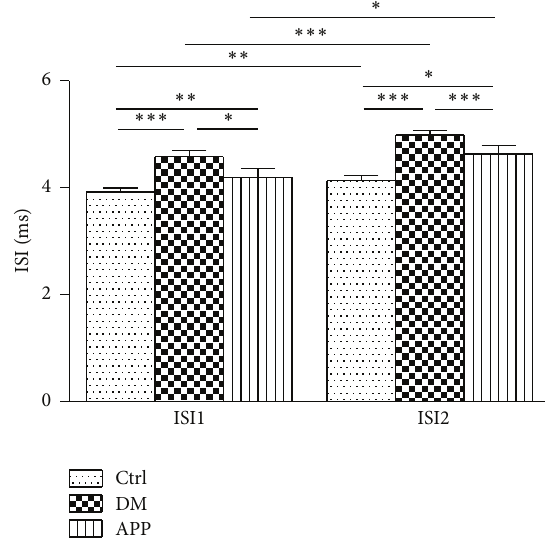
Figure 3: The intra- and intergroup comparison of intraburst ISI1 and ISI2. ISI1 and ISI2 of neurons ( 𝑛 = 59 ) recorded from DM rats were much longer than that of control rats ( 𝑛 = 26 ). APP 17 peptide treatment significantly decreased neuronal intraburst ISI1 and ISI2 ( 𝑛 = 35 ) compared with DM rats, while significant differences were also found between rats in control and APP group. In addition, ISI2 was a little longer than ISI1 in all the three groups ( ∗ 𝑃 < 0.05 ; ∗∗ 𝑃 < 0.01 ; ∗∗∗ 𝑃 < 0.001 , Mann-Whitney test). “ 𝑛 ” represents number of